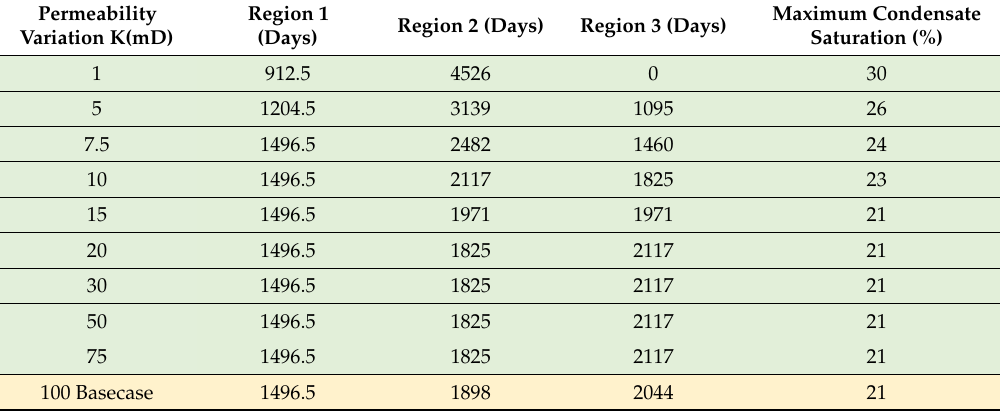
Table 2. Summary of the duration of each region and maximum condensate saturation for each case of permeability variation: local